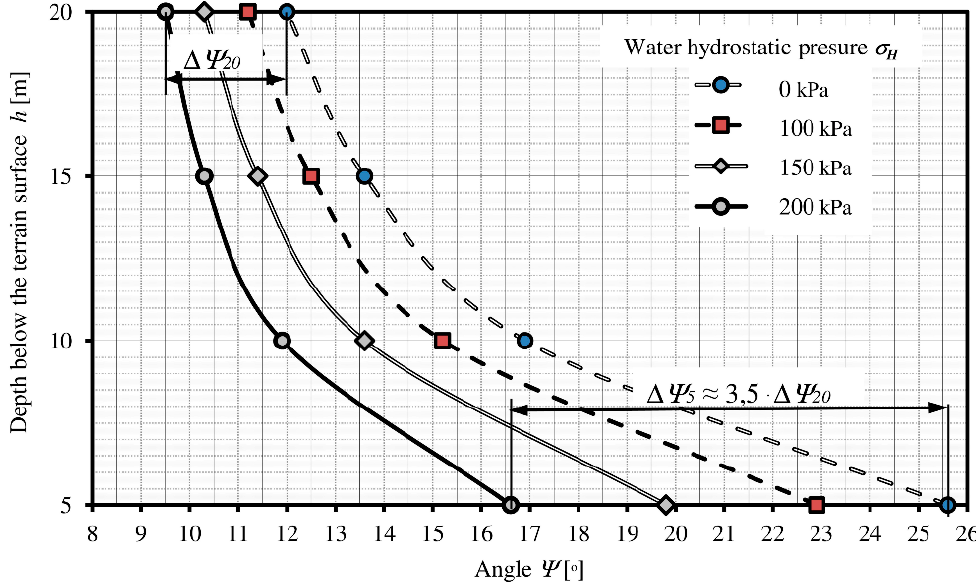
Figure 10. Dependency Ψ on the depth of deposition of the contact layer h for different values of the hydrostatic pressure σ H .